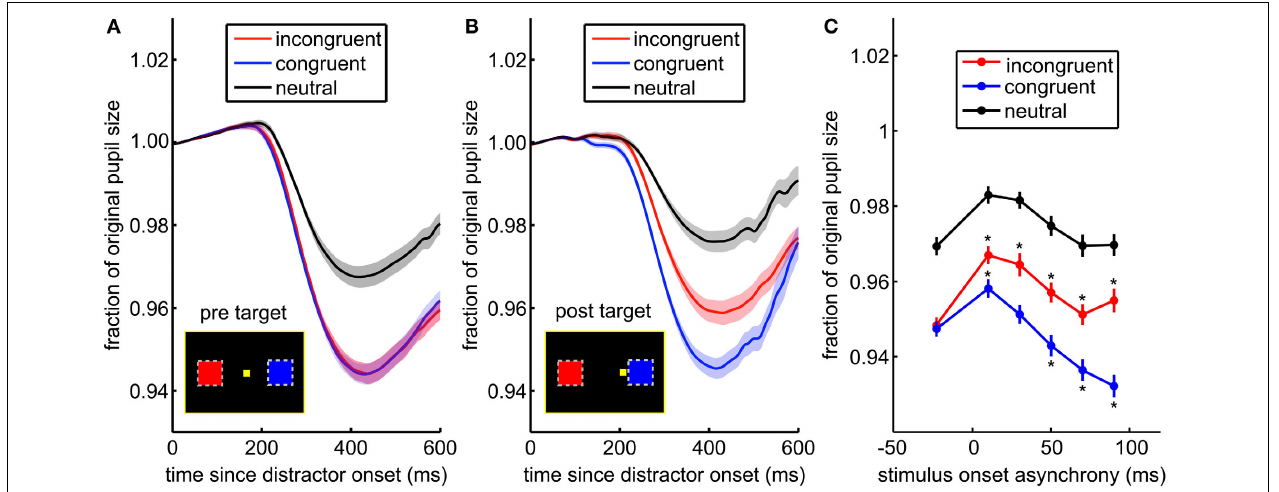
FIGURE 4 | The pupil light response is enhanced by saccade planning. (A) When the distractor was presented before the target appears, there was no difference between the pupil response to incongruent (blue) and congruent distractors (red). (B) When distractors were presented after the target, the pupil response distinguished between congruent and incongruent distractors. Shading ± s.e.m. (C) This effect is due to both suppression of the